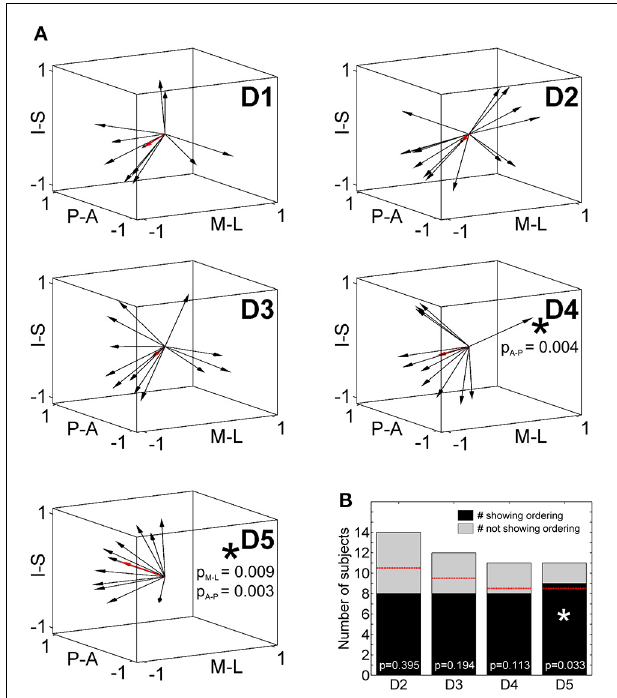
FIGURE 7 | Intra-digit direction consistency and ordering. (A) Intra-digit direction vectors for D1 to D5 (black arrows, individual direction vectors; red arrows, mean values averaged across subjects; A-P, anterior-posterior; M-L, medial-lateral; I-S, inferior-superior). Intra-digit direction consistency is indicated by an asterisk and respective p -values. (B) Intra-digit ordering as given by the number of subjects showing (black) or not showing (gray) ordered activations from p1 to p3 along the individual N vectors. The red lines illustrate the minimal number of ordered subjects needed to observe intra-digit ordering. Digits showing ordering are indicated by an asterisk and respective p -values.